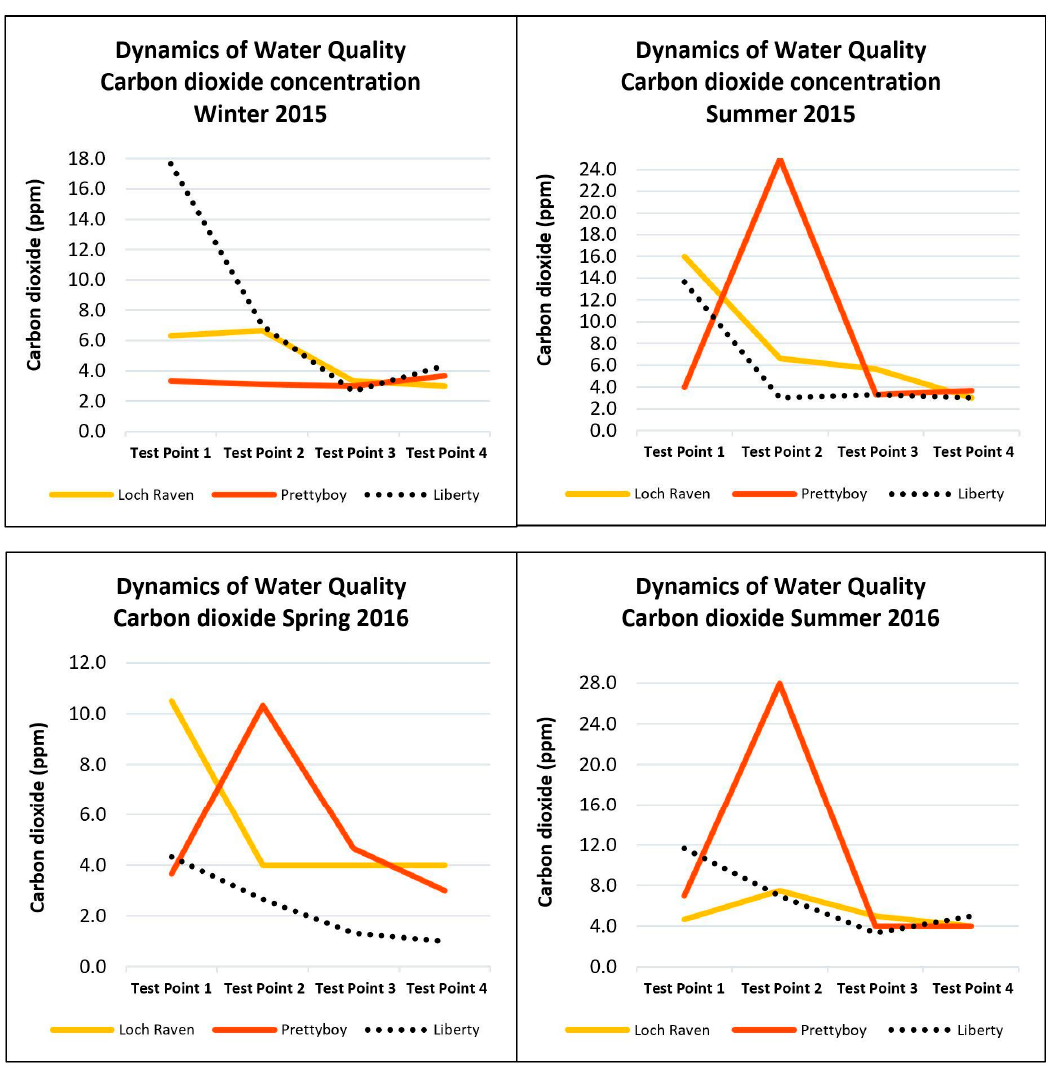
Figure 7. Dynamics of alkalinity levels in Liberty, Loch Raven and Prettyboy watersheds during 2015–2016.